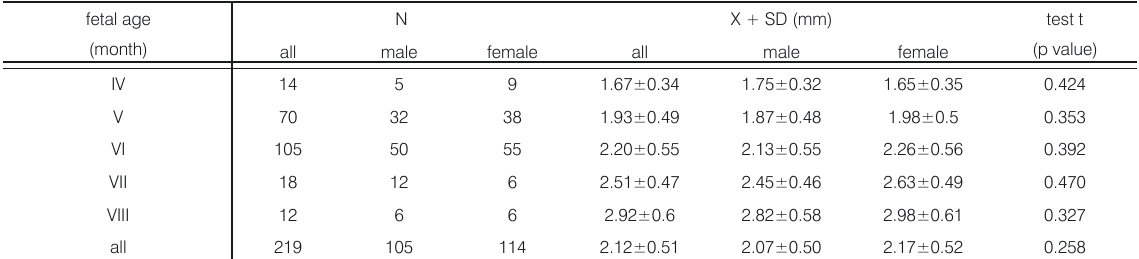
Table 2. Diameter of coronary sinus between IV-VIII months of prenatal human life. N - number, X – average, SD – standard deviation, test t-Student show gender differences.